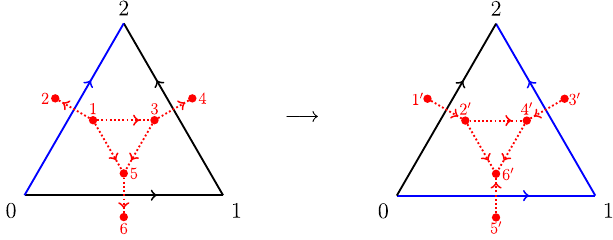
FIG. 8. Shape changing of singular lines S of T and “ gauge ˜ P transformation ” of Kasteleyn orientations of . We perform gauge transformations on the three red vertices inside a black triangle, which effectively change the shape of S and the directions of the three outreaching red links. The Majorana fermions are mapped from n to n 0 ð n ¼ 1 ; 2 ; … ; 6 Þ with respect to the directions of red links dual to black links under this